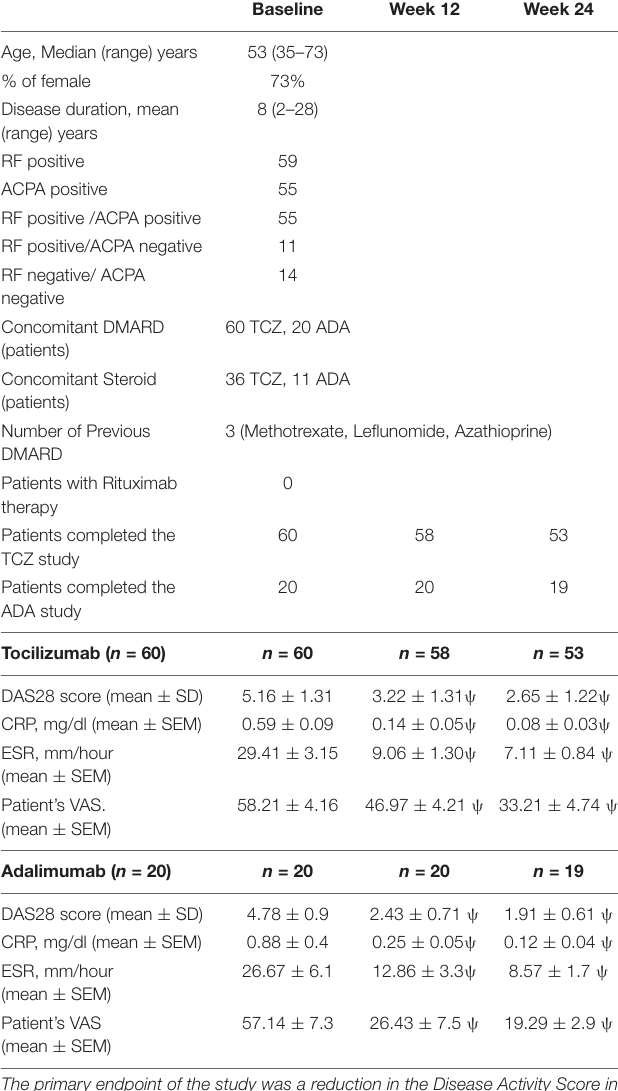
TABLE 1 | Patients characteristics and clinical evaluation of